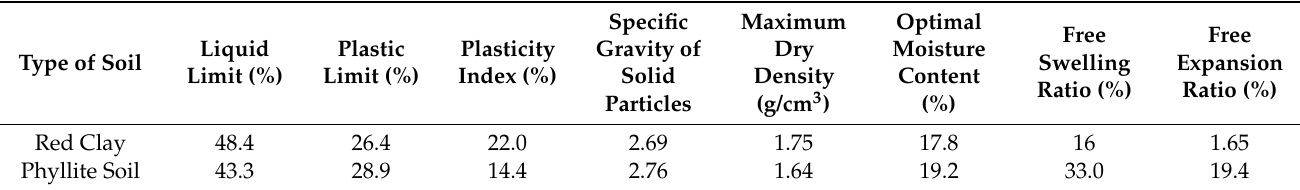
Figure 1. Two special soil materials used in the test. ( a ) General profiles of red clay and phyllite soils; ( b ) red clay stockpile; ( c ) close view of phyllite soil; ( d ) phyllite hardness. Table 1. Main physical indices of red clay and phyllite soil.